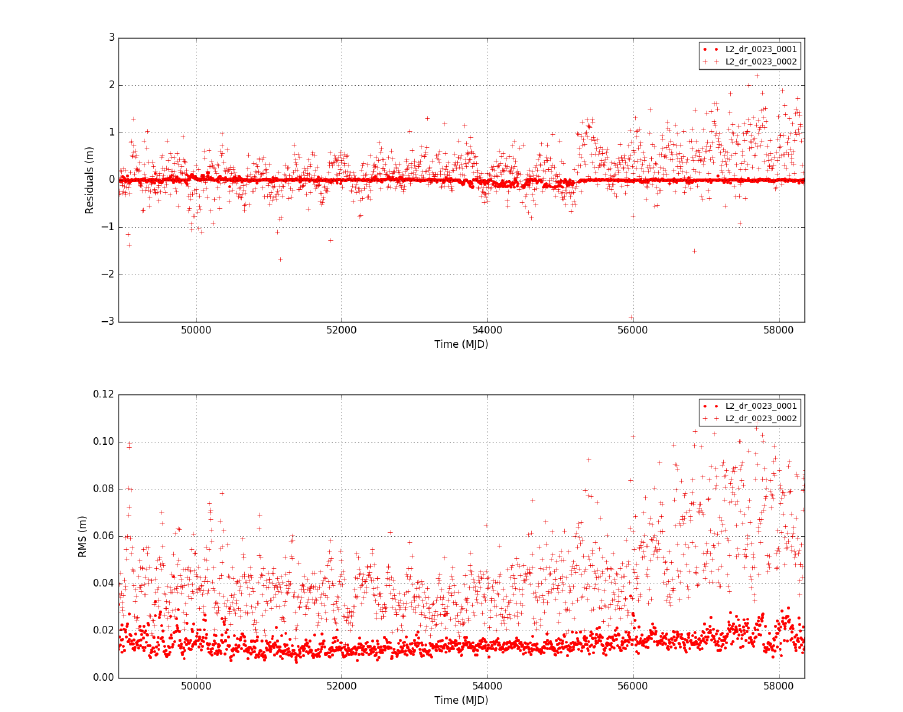
Figure 12. LAGEOS II POD results. Top: Range residuals. Bottom: RMS of the range